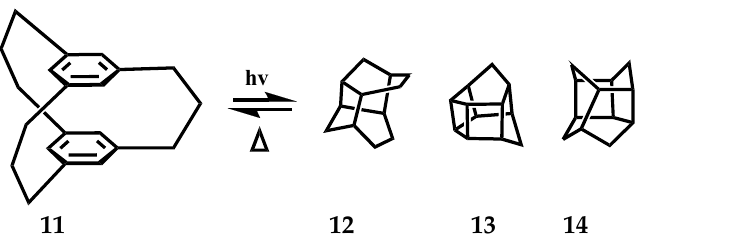
Figure 9. Compound 11 generates a photochemical reaction formula of the new cage compounds 12 , 13, and 14 to show only the cage backbone for clarity.